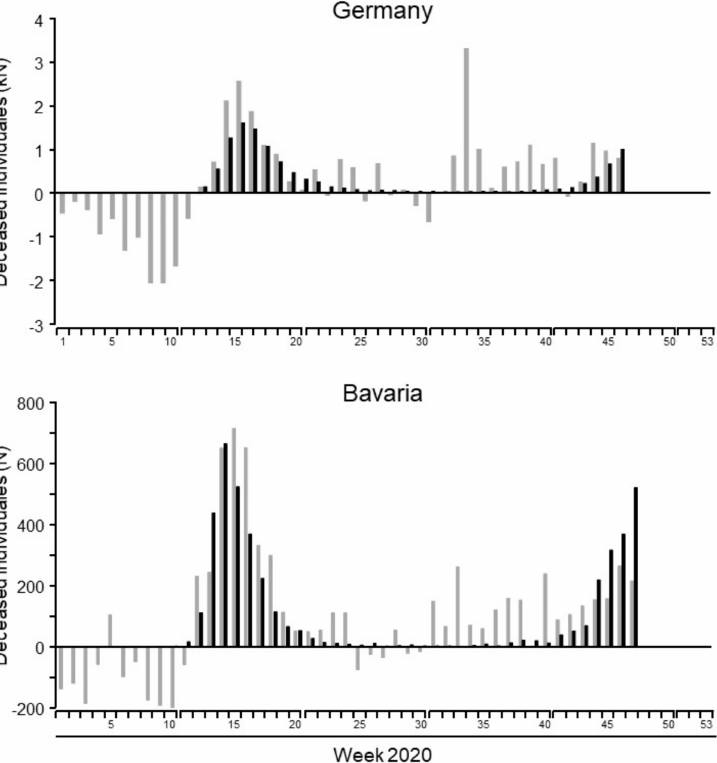
Figure 5. Excess mortality of 2020 in relation to the average mortality 2016–2019 (grey columns) and COVID-19-caused mortality (black columns) in Germany and Bavaria per week of 2020. Data Figure 95. masks became mandaTable 19. patients and surging infection rates (Figure 6).